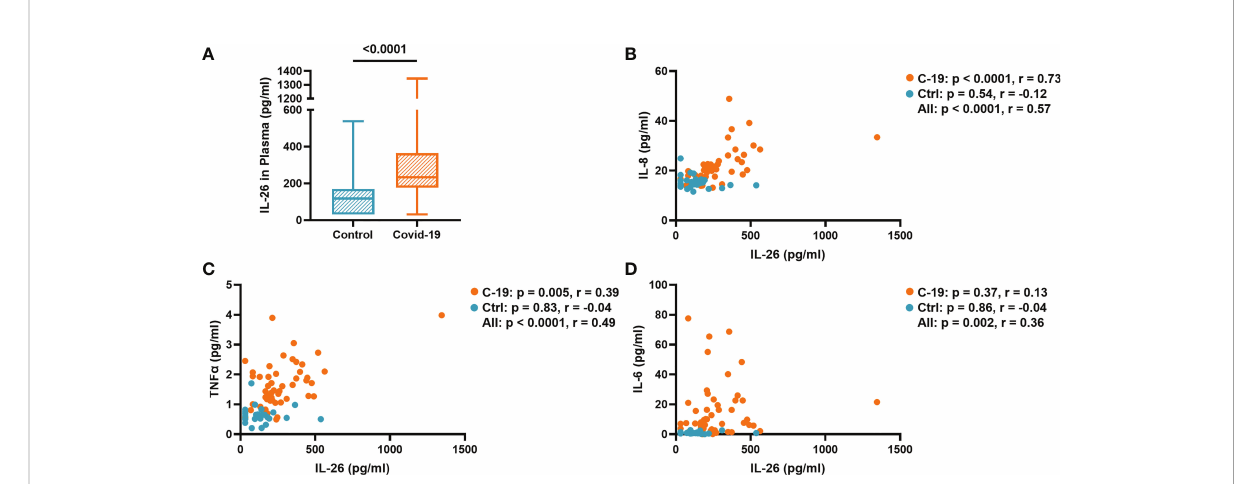
FIGURE 1 The plasma concentration of IL-26 is associated with those of IL-8, TNF a , and IL-6. (A) Comparison between the plasma concentration of IL-26 in the COVID-19 and Control groups tested by unpaired Mann-Whitney test. Spearman correlation analyses of the plasma concentration of IL-26 with those of (B) IL-8, (C) TNF a , and (D) IL-6 in the COVID-19 (orange) and Control (blue)